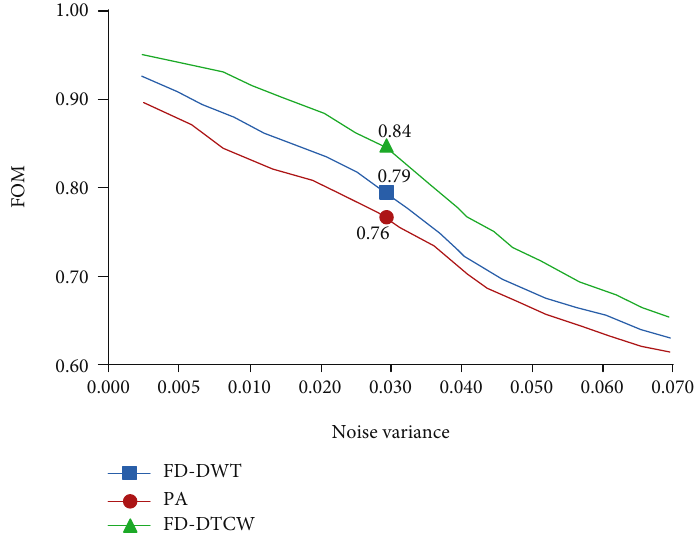
Figure 11: FOM changes of each model on the test set.